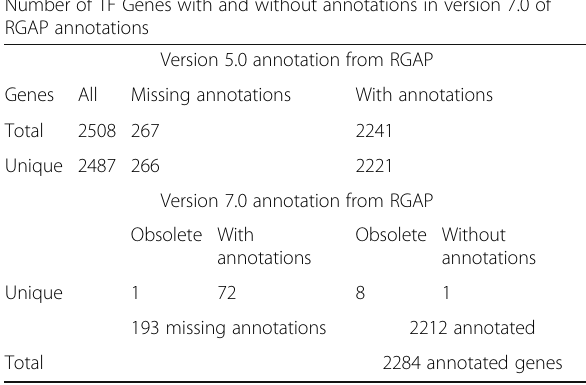
Table 1 Summary of the total number of genes with and without annotations in the RGAP pseudomolecules version